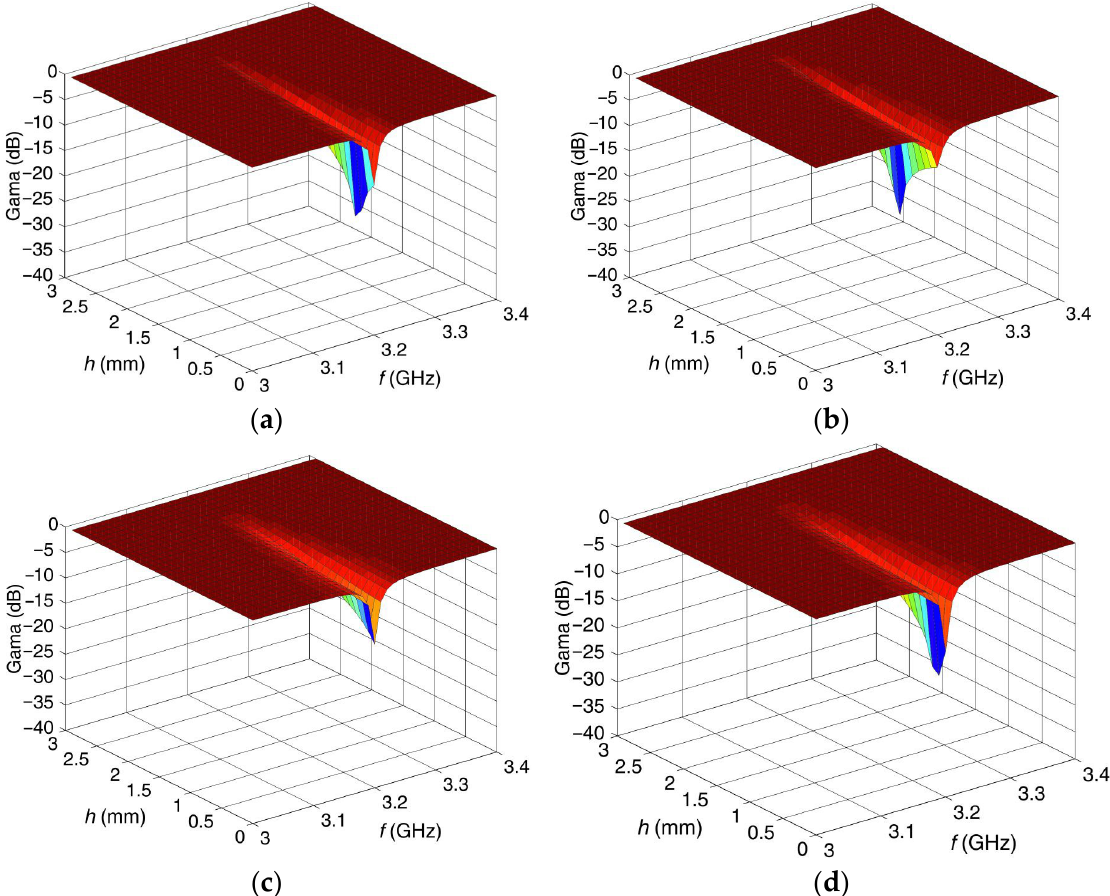
Figure 3. Reflection coefficient vs. frequency and dipole height of a dipole situated on a foam sub- strate above an infinite metallic plane. ( a ) Narrow dipole 46 × 0.2 mm 2 , copper; ( b ) wide dipole 46 × 1 mm 2 , copper; ( c ) narrow dipole 46 × 0.2 mm 2 , silver paste; ( d ) wide dipole 46 × 1 mm 2 , silver paste.